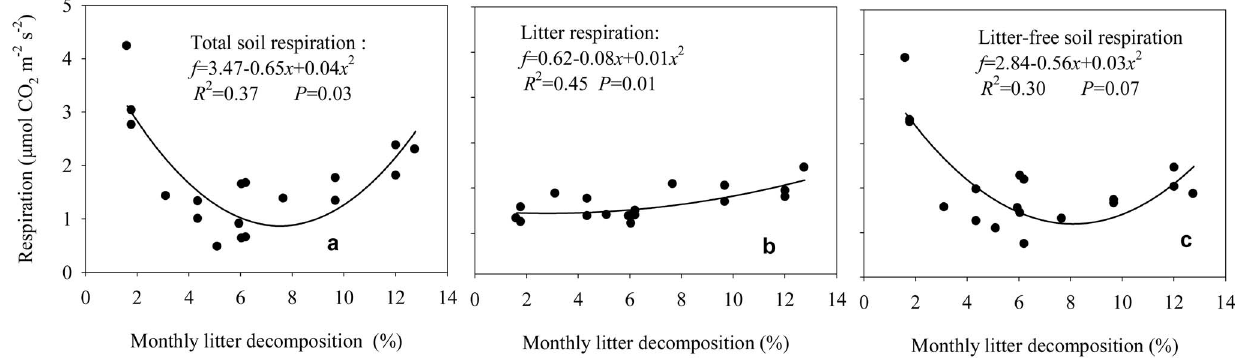
Figure 3. Relationships between mean monthly litter decomposition and the total soil respiration (a), litter respiration (b), and litter-free soil respiration rate (c) for different-aged Pinusmassoniana forests. Note: respiration rate is the mean value across the litter decomposition period.